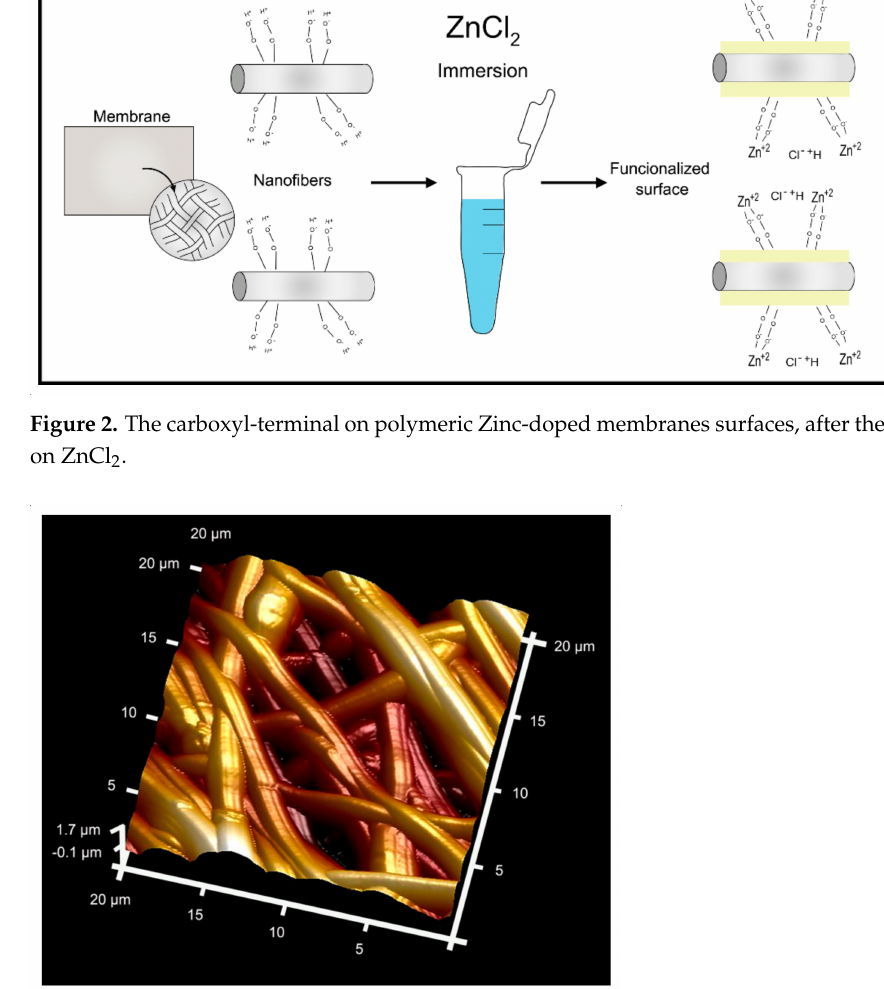
Figure 3. AFM image of the surface’s Zn-matrix. Overlapped and randomly